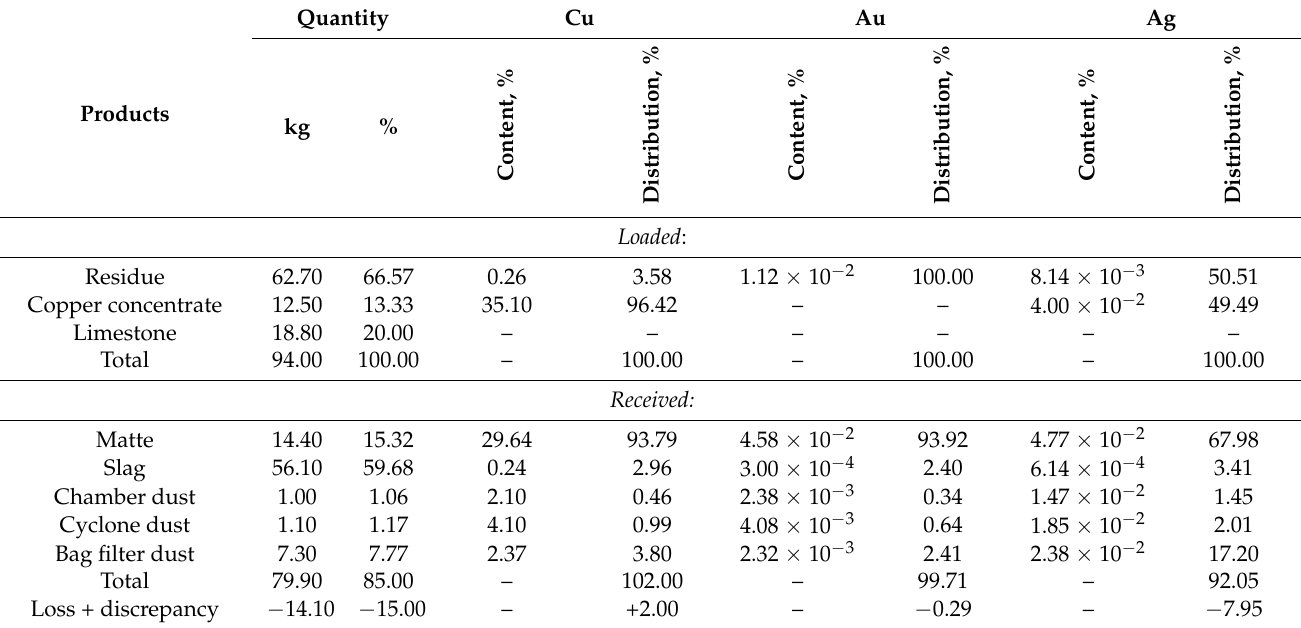
Table 5. Metal distribution during cyclonic smelting of arsenic sublimation residue from Bakyrchik flotation concentrate.